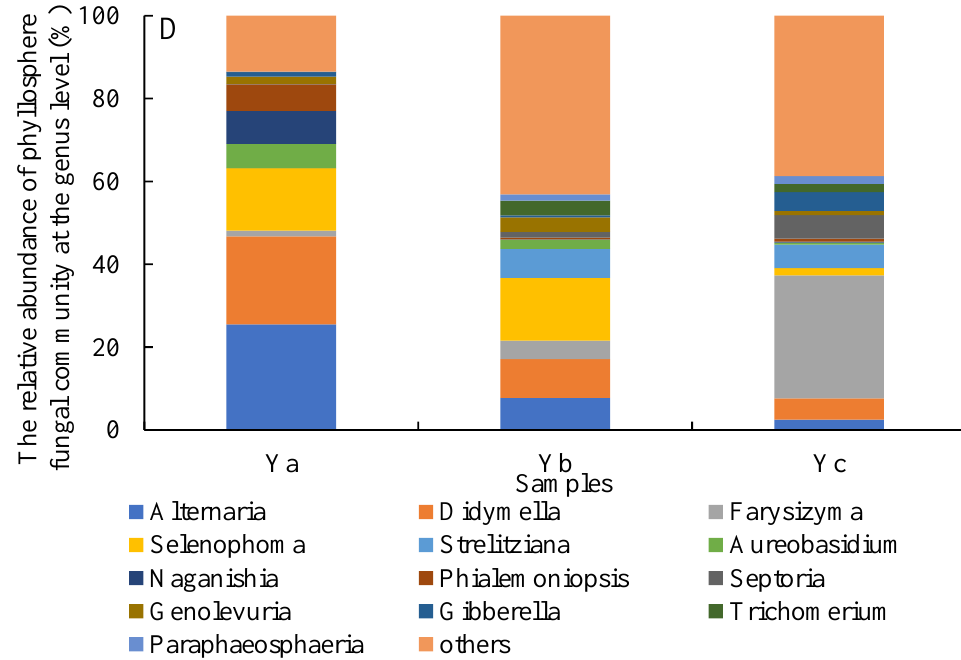
Figure 3. The relative abundances of phyllosphere bacterial ( A , B ) and fungal ( C , D ) community compositions at the phylum and genus levels. Different lower-case letters in the same row indicate significant differences at p < 0.05. Ya: healthy Pinus tabuliformis trees; Yb: diseased P. tabuliformis trees at an early stage of B. xylophilus infection; Yc: diseased P. tabuliformis trees in the last stage.